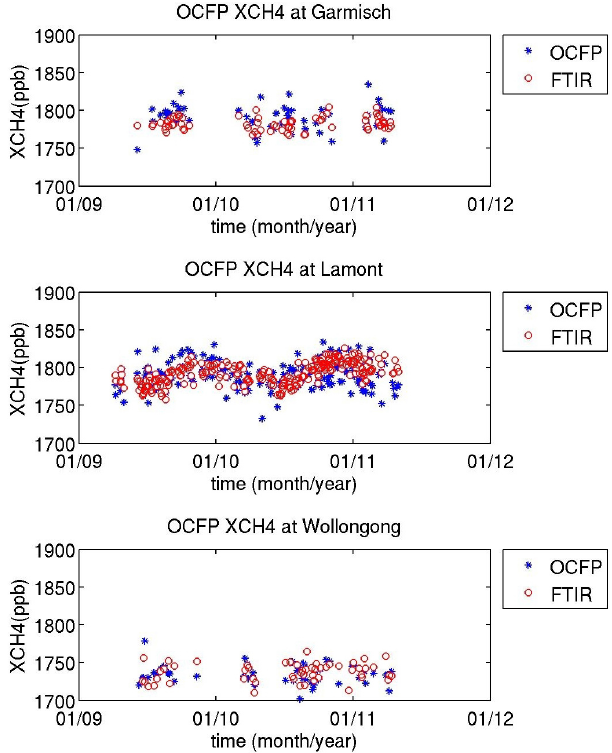
Figure 13. Daily averaged time series of paired OCPR and TC- CON FTIR XCH 4 at Garmisch (top), Lamont (mid) and Wollon- gong (bottom).